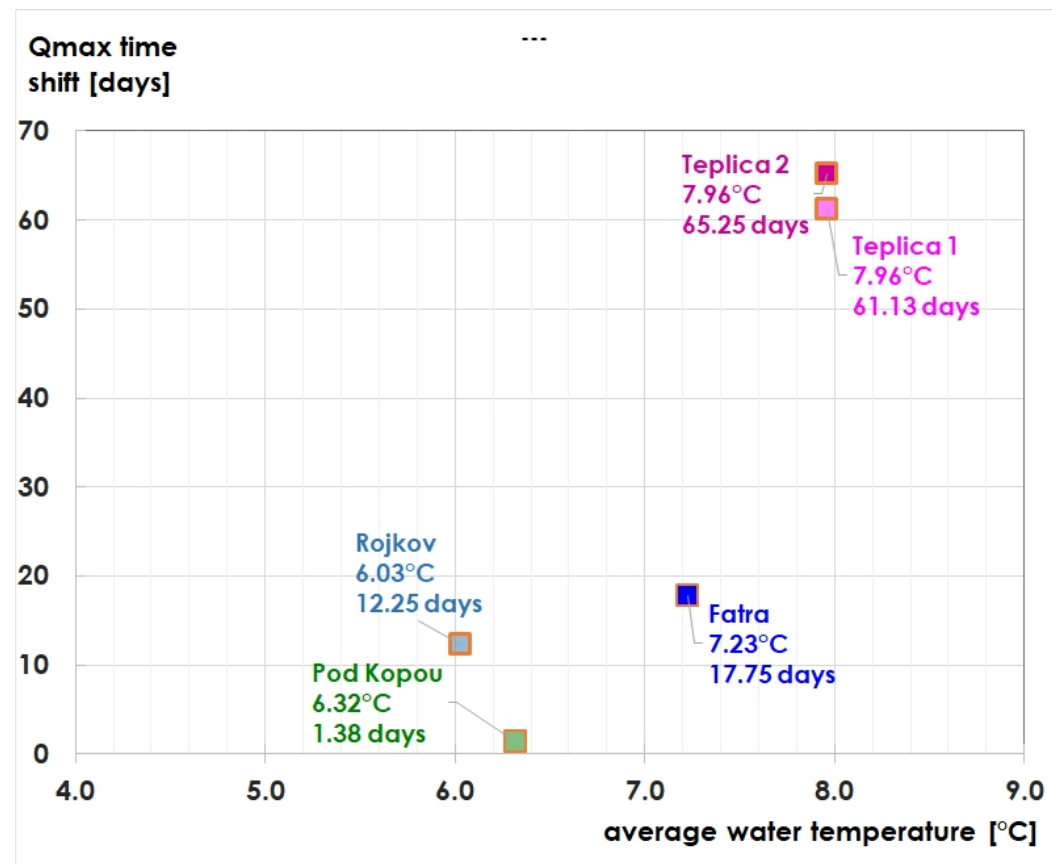
Figure 14. Mean groundwater temperature vs. time shifts of discharge culminations in individual monitored springs of the Kopa Mt. karstic aquifer. The first number under the name of spring indicates groundwater temperature and the lower number marks peak arrival time shift in